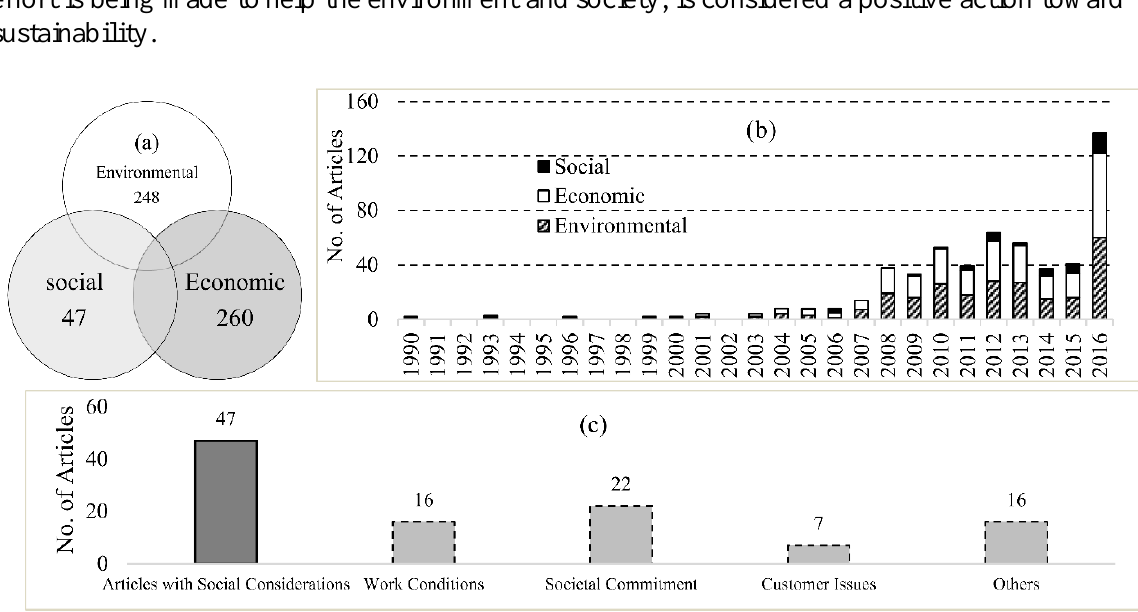
Figure 6. a) The portion of different dimensions of sustainability b) the frequency of each dimension in desired horizon; c) The frequency different social sub-dimensions in the reviewed